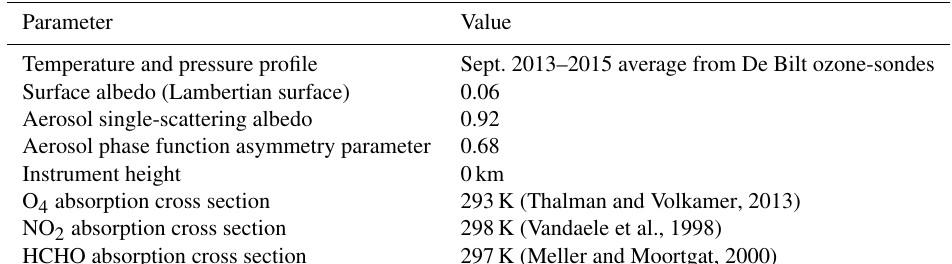
Table 5. RTM parameters for the radiative transfer modelling.